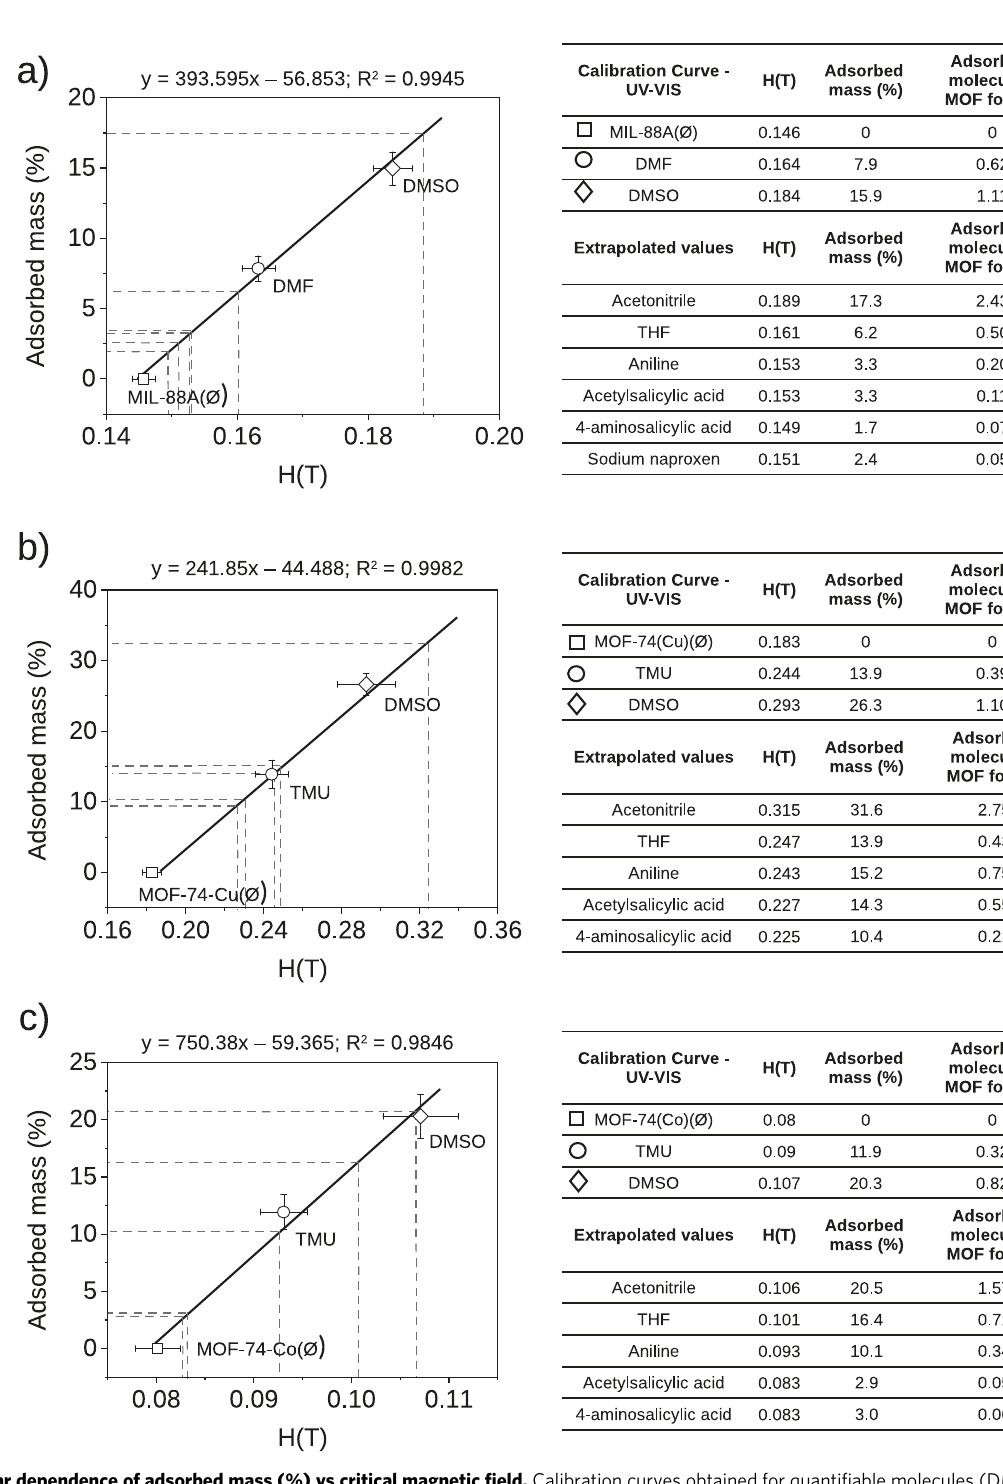
Fig. 7 Linear dependence of adsorbed mass (%) vs critical magnetic fi eld. Calibration curves obtained for quanti fi able molecules (DMSO, DMF, TMU) by UV-VIS spectroscopy and the extrapolated values for the other adsorbates represented in a table: a MIL-88A(Fe), b MOF-74(Cu) and c MOF-74(Co). For the calibration curves each measurement was repeated fi ve times in order to provide the corresponding associated statistical